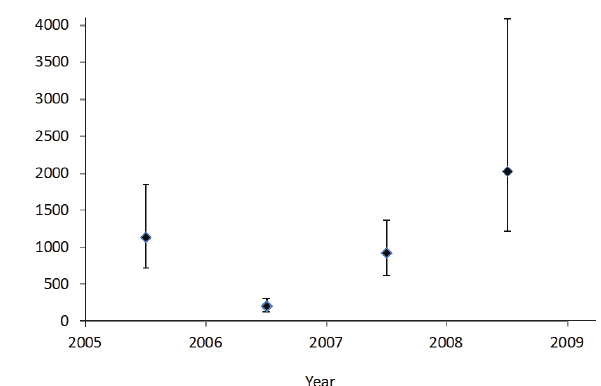
Figure 3. Abundance estimates for the HHH in central Alaska. Error bars represent 90% confidence intervals. Due to insufficient data during summer, all estimates are from winter which includes surveys conducted from August of one year to April of the next year. Note, the estimate during the winter of 2006 – 2007 is likely unreliable because it is from 1 flight in March when all telemetered individuals were seen in 2 groups (i. e, 4 collars in a group of 150 and 2 collars in a group of